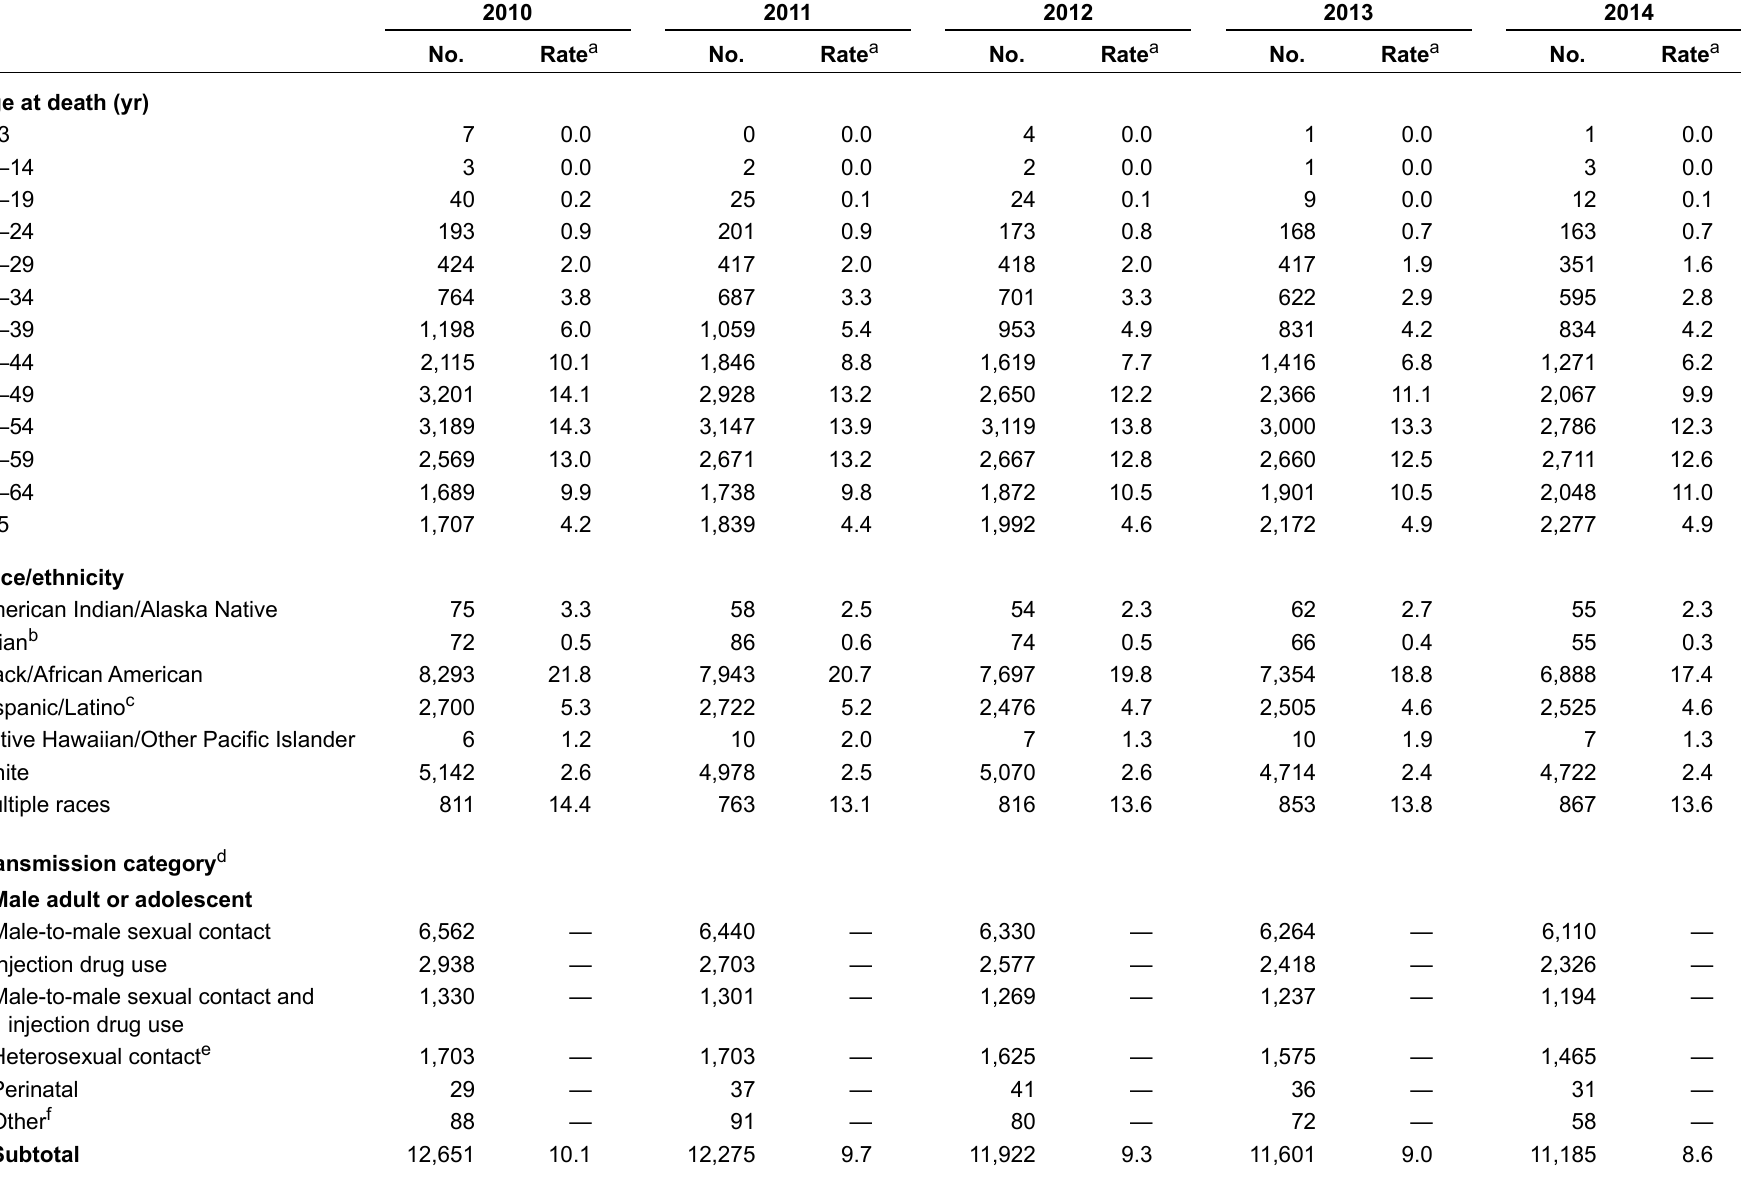
Table 12a. Deaths of persons with diagnosed HIV infection, by year of death and selected characteristics, 2010–2014—United